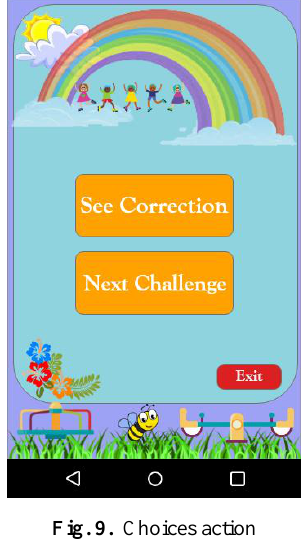
Fig. 9. Choices action